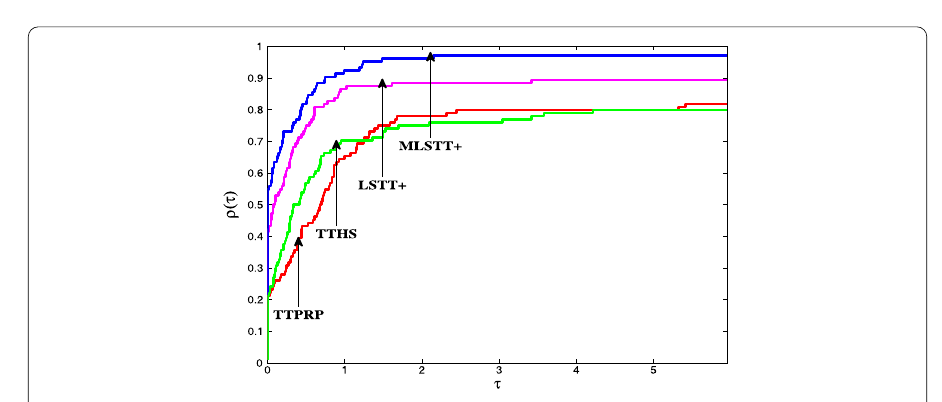
Figure 3 Performance profiles on NG of four CG